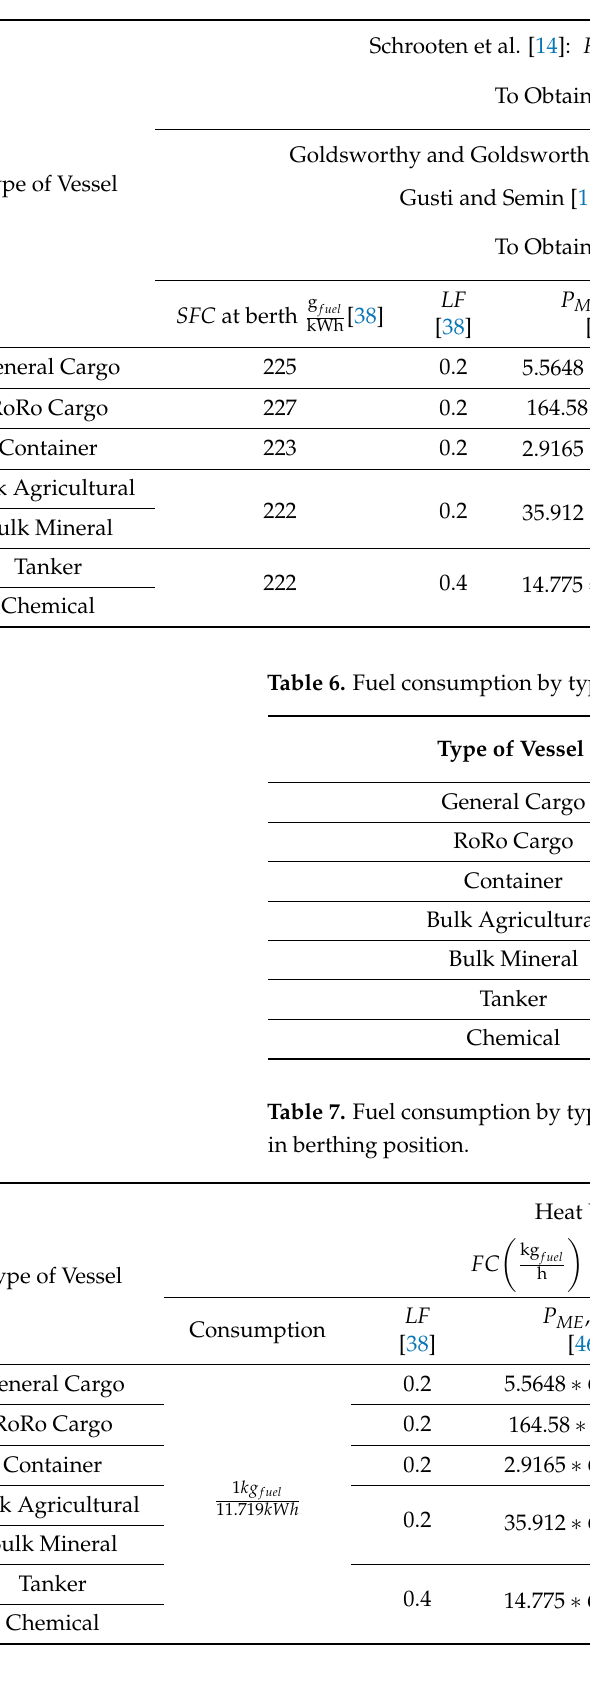
Table 5. Fuel consumption by type of ship, case of berthing situation (Schrooten et al. [14], Goldswor- thy and Goldsworthy [16], and Gusti and Semin [17]).